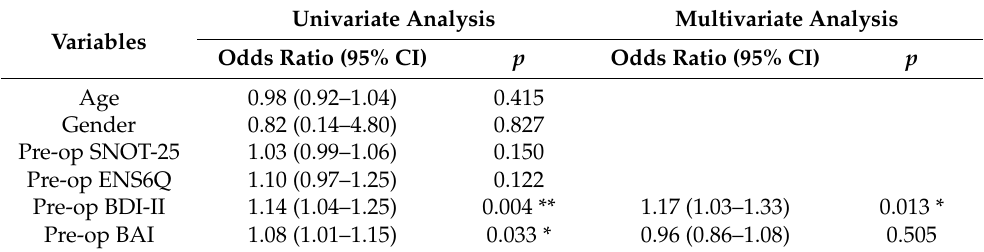
Table 2. Regression analysis for postoperative residual psychological symptoms.